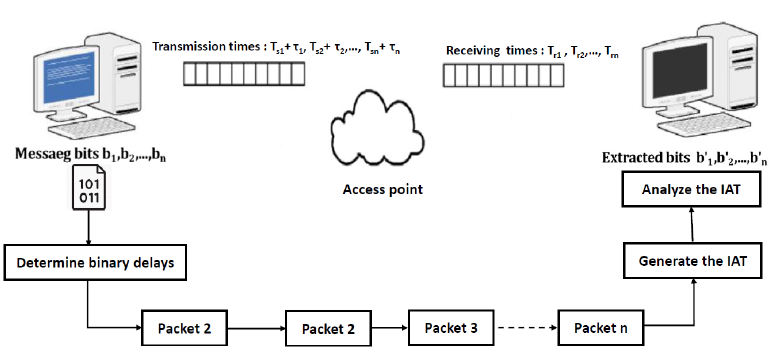
Figure 1. Scheme of encoding binary symbols to the inter arrival time .